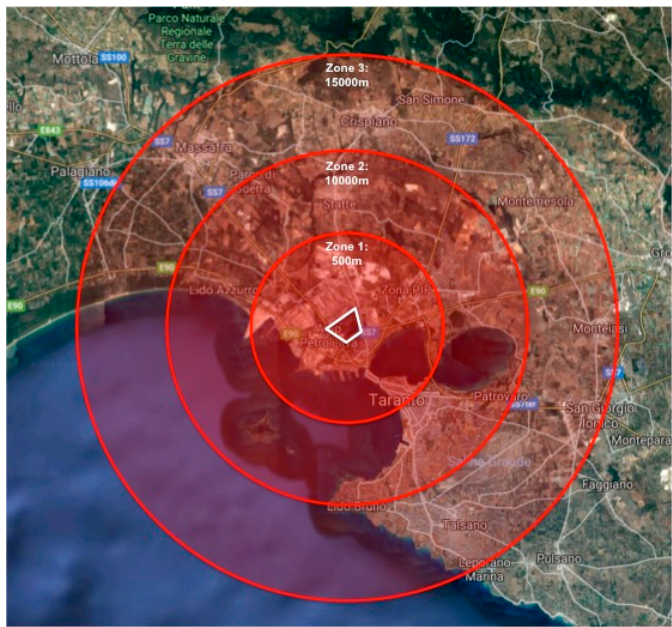
Figure 1. Geographic description of the residential zones (circles) used to define participant proximity to the industrial complex (polygon).